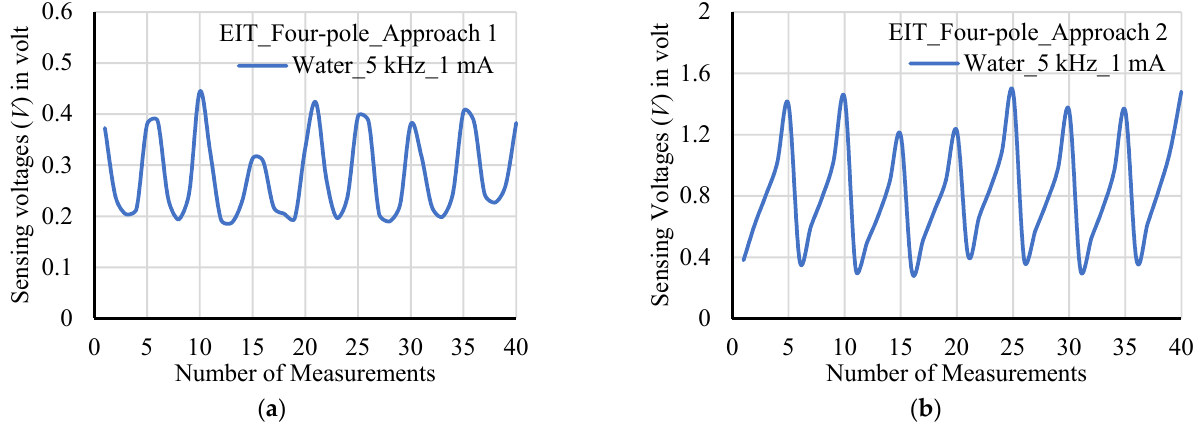
Figure 8. The sensing voltages for a homogeneous media (water) at 5 kHz and 1 mA signal